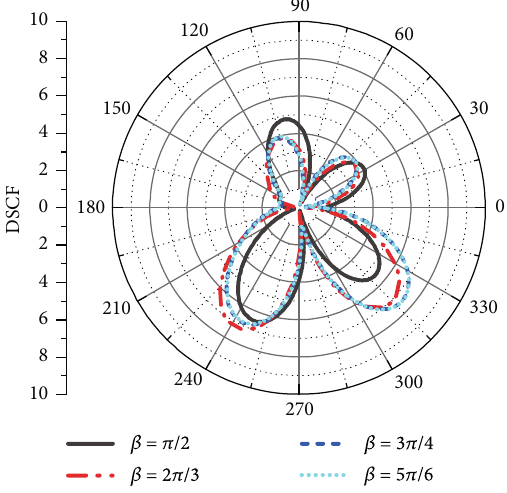
Figure 11: DSCF distribution of the circular hole for di ff erent values of β ( α 0 = 0 °